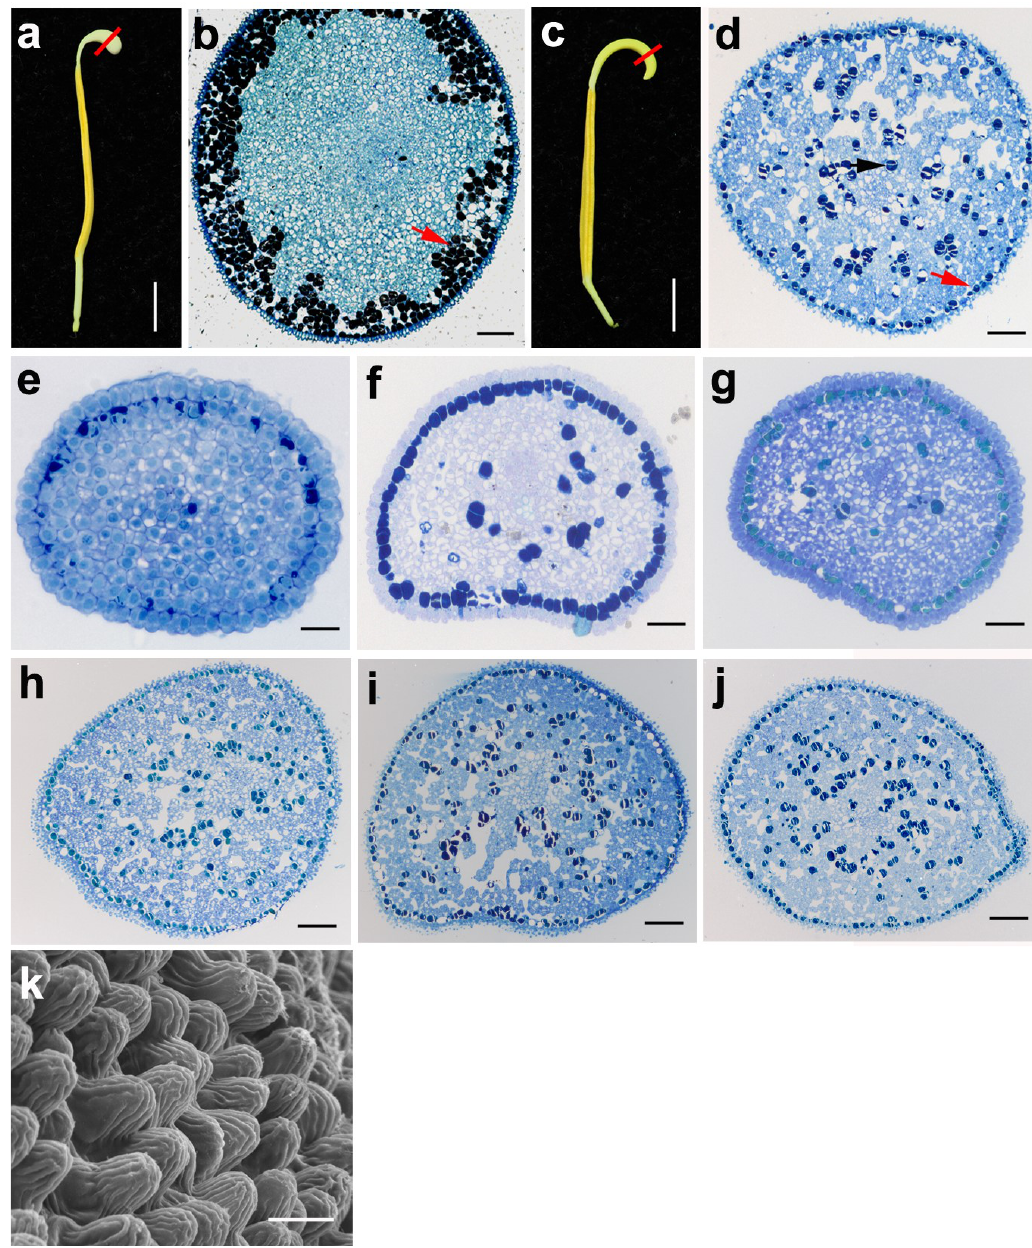
Figure 7. The structural comparison of the anther and its appendage between N. nucifera ( a , b ) and N. lutea ( c – k ). ( a ) The morphology of the mature anther; the red line indicates the place for cross section. ( b ) Cross section of the anther appendage, the red arrow indicates the osmiophilic bodies accumulated with the multiple layers under the epidermis cells. ( c ) The morphology of the mature anther; the red line indicates the place for the cross section. ( d ) Cross section of the appendage, the arrows indicate the osmiophilic bodies randomly scattered in the parenchyma cells. ( e – j ) Transverse section of the anther appendage at the microspore mother cell stage ( e ), the tetrad stage ( f ), the early young microspore stage ( g ), the middle free spore stage ( h ), the late young microspore stage ( i ) and the mature stage ( j ). ( k ) The scanning electron micrograph of the surface structure of the anther appendage at the mature stage. ( a , c ) Bar = 1 cm; ( b , d , g – j ) Bar = 100 μm; ( e , f ) Bar = 20 μm; ( k ) Bar = 10 μm.